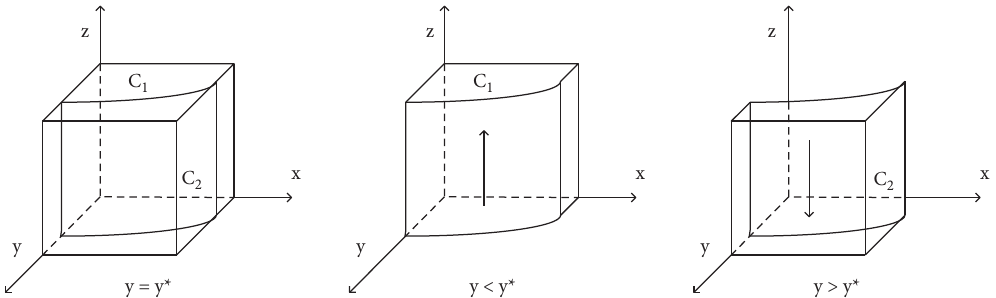
Figure 4: Phase diagram of the government’s strategy